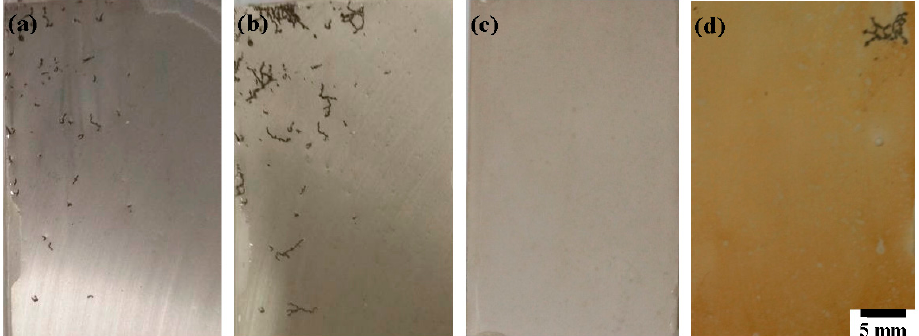
Figure 7. Optical morphology of ( a , b ) the AM60 substrate and ( c , d ) the sample coated with film after immersion tests for 12 h and 24 h in 0.6 M NaCl, respectively.